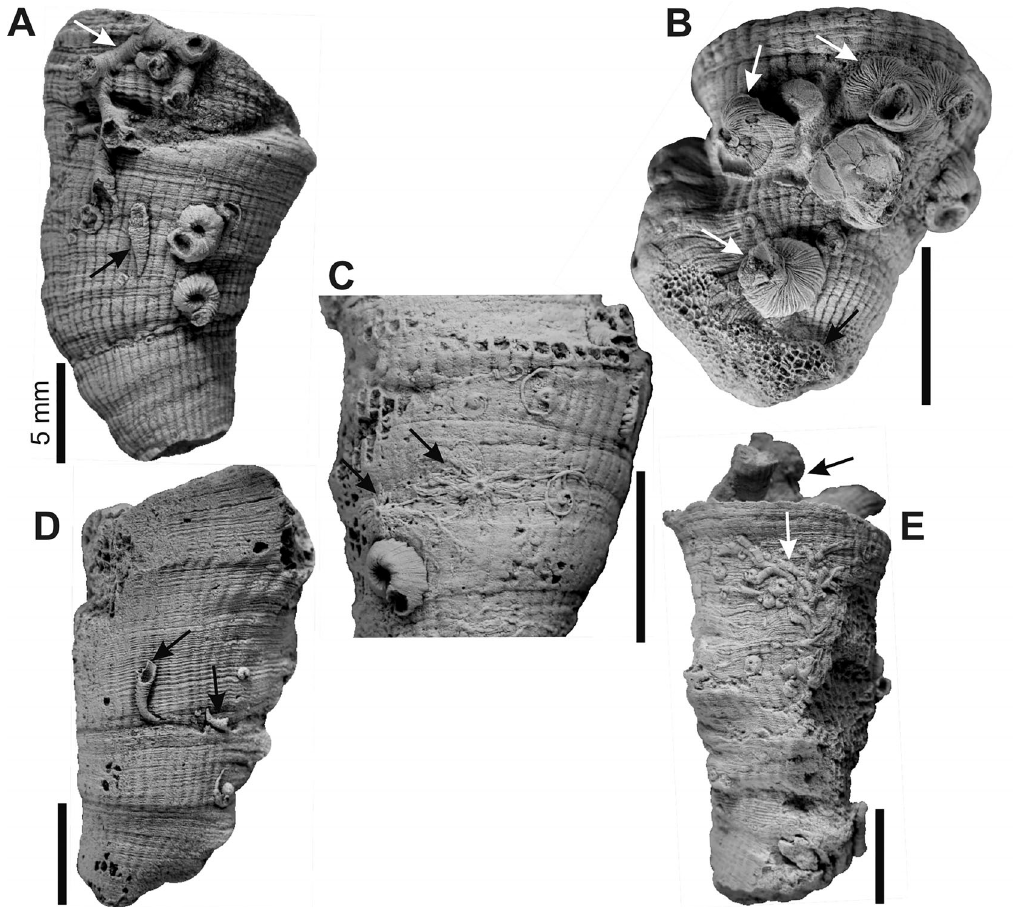
Fig. 5. Encrusted rugose corals from Saaremaa Island, Estonia. A , auloporids (white arrow), cornulitid Conchicolites (black arrow) and two associated microconchids, GIT 687-3, Kuressaare. B , Anticalyptraea (white arrows) and trepostome bryozoan colony (black arrow), GIT 687-8, Muratsi. C , ascodictyids (black arrows) and associated microconchids, GIT 687-7, Kuressaare. D , cornulitid Conchicolites (black arrows), GIT 687-11, Kuressaare. E , rugose spatfalls within the calyx (black arrow) and a hederelloid colony (white arrow), GIT 687-13, Kuressaare.